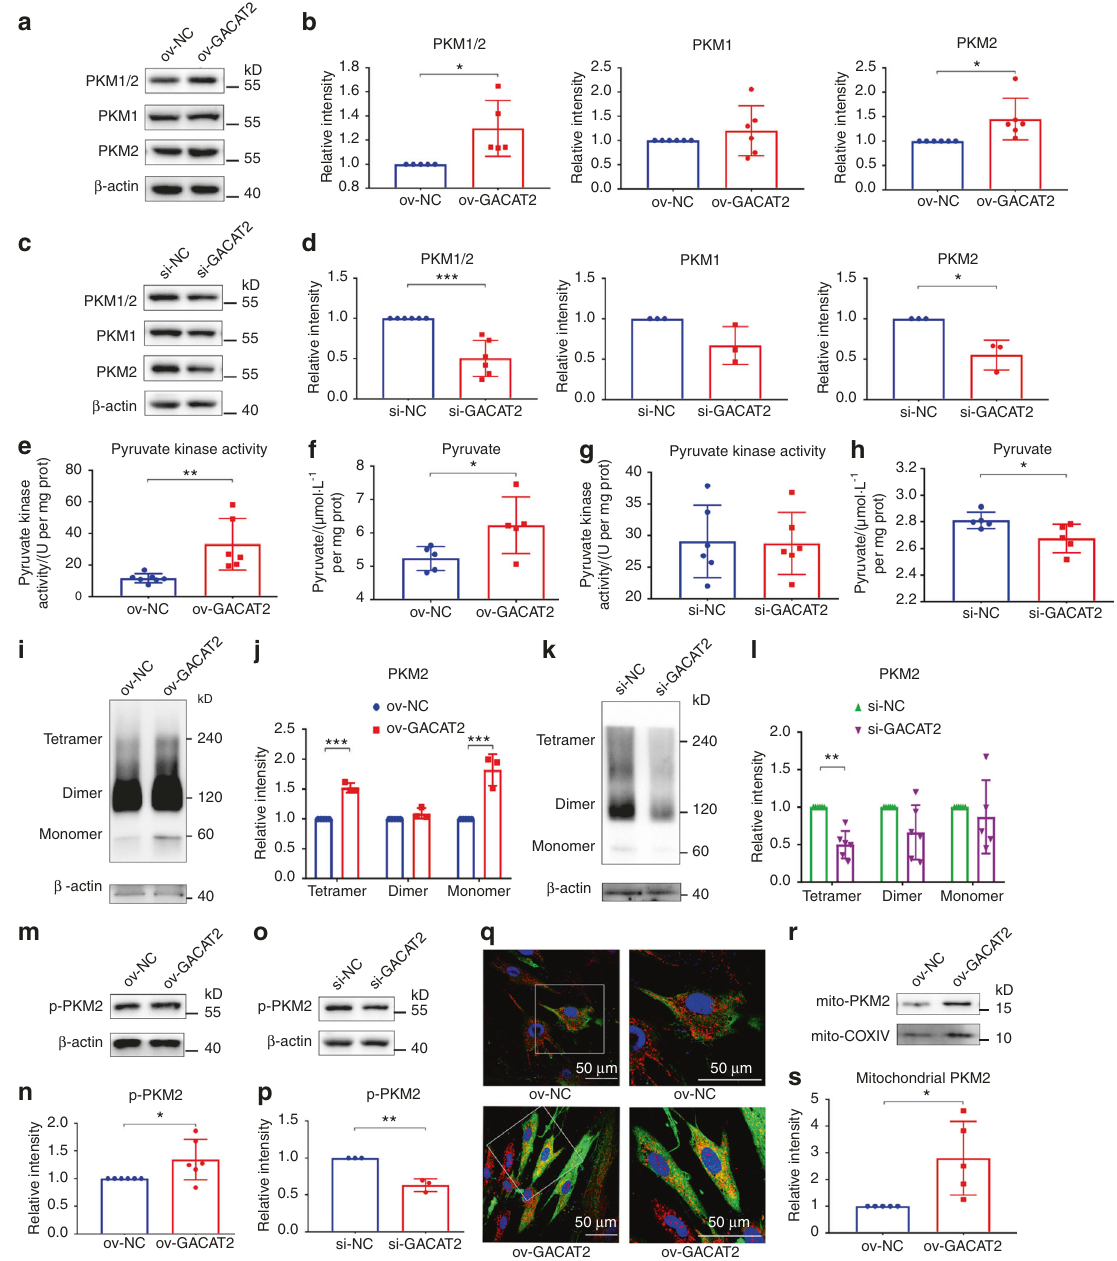
Fig. 7 Overexpression/inhibition of GACAT2 affects the expression, activity, allosteric regulation, post-translational modi fi cation and translocation of PKM1/2. a – d Relative protein expression levels of PKM1/2, PKM1 and PKM2 in PDLSCs (with overexpression or inhibition of GACAT2 ) determined by Western blots and semiquantitative analysis of their expression levels (normalized to β -actin) in terms of relative gray density. The cells were transfected with ov-NC or ov- GACAT2 and incubated in medium with both in fl ammatory cytokines and EMD (in fl ammatory environment) ( a and b ) or were transfected with si-NC or si- GACAT2 and incubated in medium with the cementoblastic inducer EMD (nonin fl ammatory environment) ( c and d ). e – h PK activity and production of pyruvate in PDLSCs (with the overexpression or inhibition of GACAT2 ). The cells were transfected with ov- NC or ov- GACAT2 and incubated in an in fl ammatory environment ( e and f ) or were transfected with si-NC or si- GACAT2 and incubated in a nonin fl ammatory environment ( g and h ). i – l Tetramer, dimer and monomer levels of PKM2 in PDLSCs (with overexpression or inhibition of GACAT2 ) determined by western blots ( i and k ) and semiquantitative analysis of their expression levels (normalized to β -actin) in terms of relative gray density ( j and l ). The cells were transfected with ov-NC or ov- GACAT2 and incubated in an in fl ammatory environment ( i and j ) or were transfected with si-NC or si- GACAT2 and incubated in a nonin fl ammatory environment ( k and l ). m – p p-PKM2 in PDLSCs (with overexpression or inhibition of GACAT2 ) was determined by western blots and semiquantitative analysis of their expression levels (normalized to β -actin) in terms of relative gray density. The cells were transfected with ov-NC or ov- GACAT2 and incubated in an in fl ammatory environment ( m and n ) or were transfected with si- NC or si- GACAT2 and incubated in a nonin fl ammatory environment ( o and p ). q Immuno fl uorescence staining for mitochondria (MitoTracker, red), PKM2 (green) and DAPI (blue) in the PDLSCs transfected with ov-NC or ov- GACAT2 and incubated in an in fl ammatory environment (scale bar: 50 μ m). r and s Relative protein expression levels of mitochondrial PKM2 in PDLSCs (with overexpression of GACAT2 ) determined by Western blots ( r ) and semiquantitative analysis of their expression levels (normalized to COXIV) in terms of relative gray density ( s ). The data are shown as the mean ±SD for n from 3 to 6; * P < 0.05, ** P < 0.01 and *** P < 0.001 indicate signi fi cant differences between the indicated